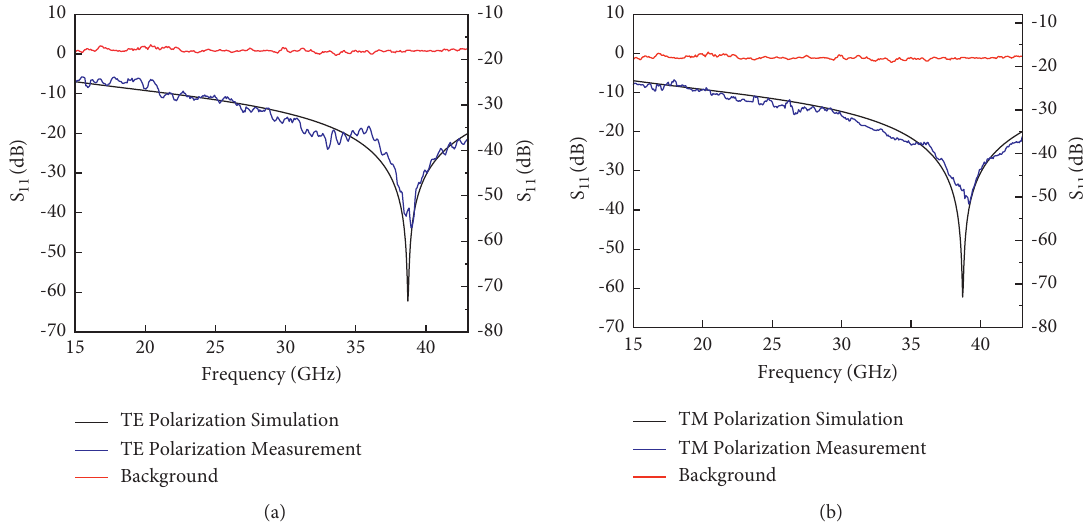
Figure 22: Simulation (left column) and measurement (right column) results: (a) TE polarization and (b) TM